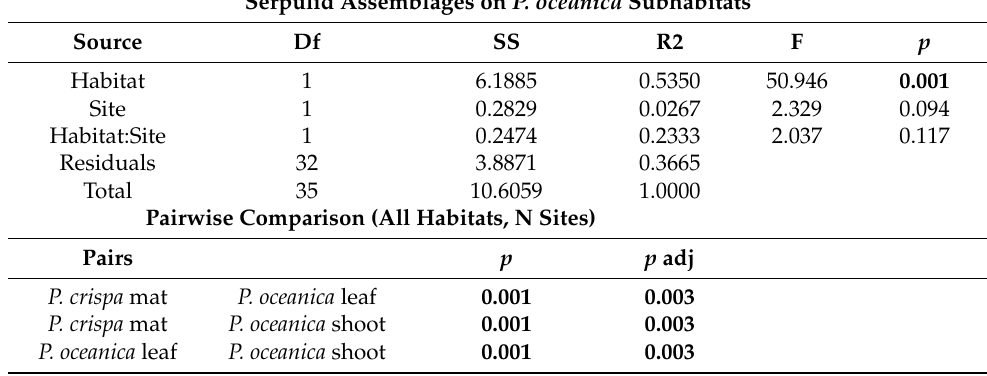
Table 1. Results of permutational multivariate analysis of variance (PERMANOVA) of Serpulid assemblages among P. oceanica subhabitats (shoots and leaves), and pairwise comparison of all habitats on the northern sites (site PC1, PC2, PO and mix). Significant results are indicated in bold. Serpulid Assemblages on P. oceanica